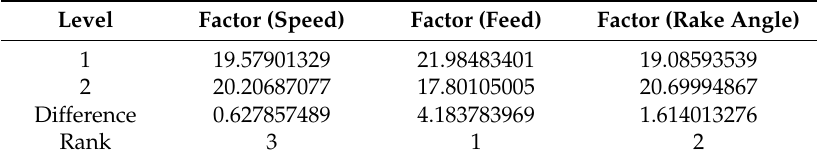
Table 5. Response table for S/N